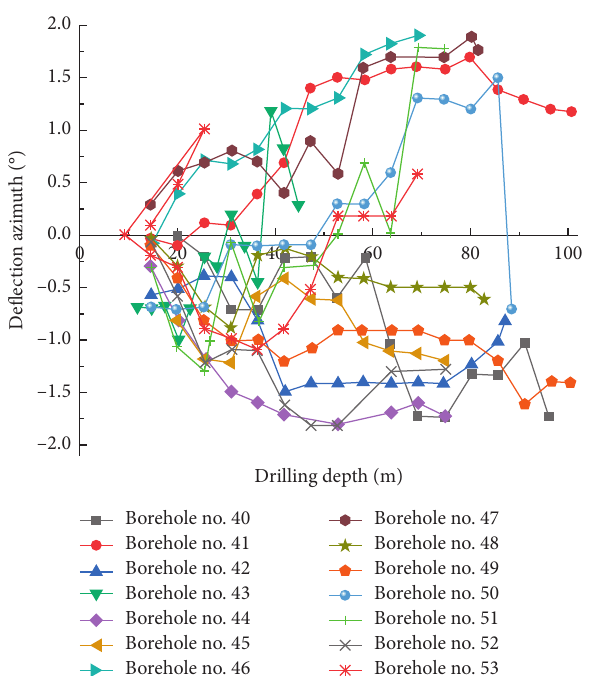
Figure 3: Azimuth change